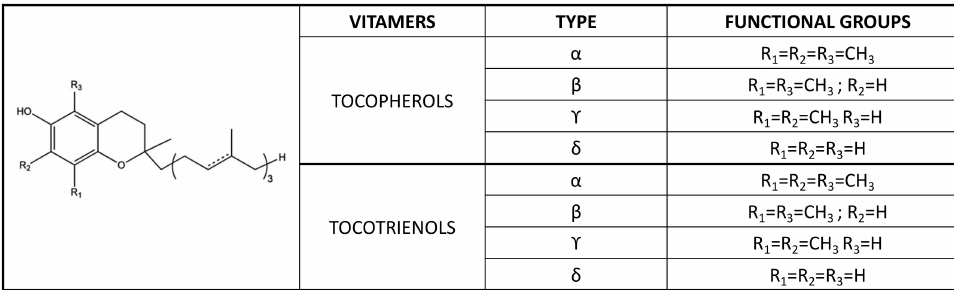
Figure 1. Structure and systematics of the main tocopherol and tocotrienol forms. These two subgroups of vitamers are characterized by an aliphatic phytyl side chain and an unsaturated farnesyl side chain,